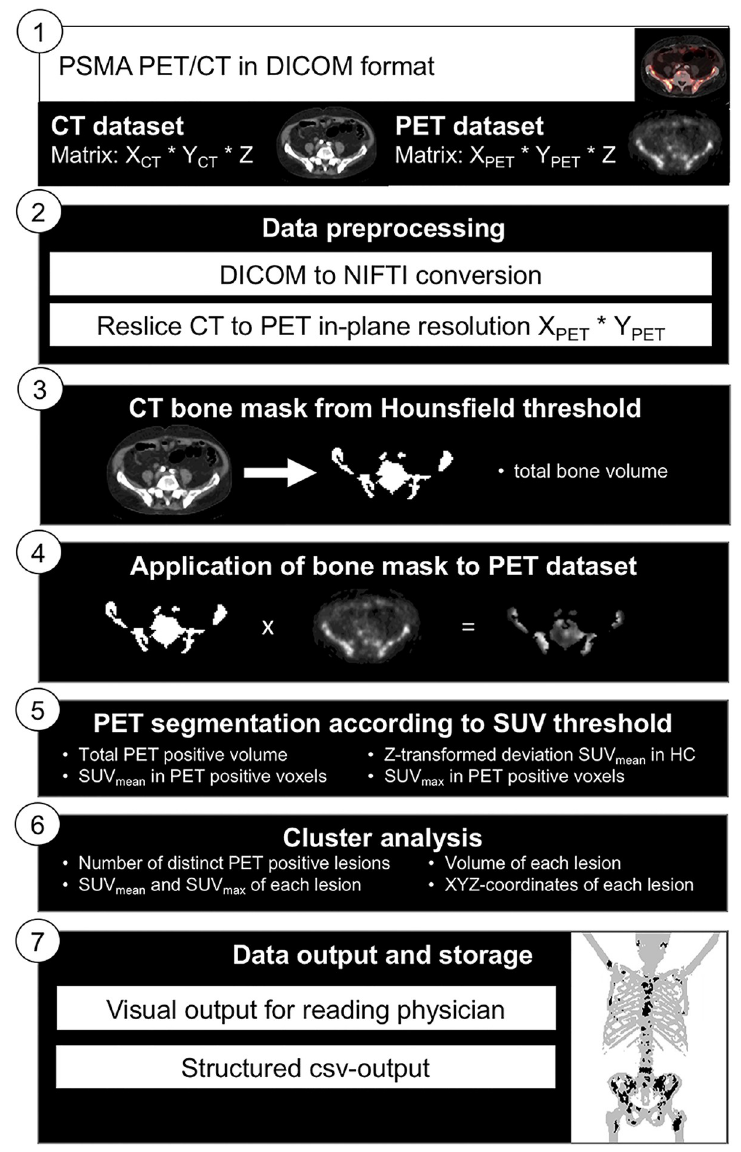
Fig 1. Algorithmic functionality of automated bone-VOI delineation and metastasis load quantification with EBONI in an exemplary patient with known osseous metastases of prostate cancer. csv = comma-separated values; HC = healthy controls. This figure was originally published in JNM [10]. Hammes et al. EBONI: A Tool for Automated Quantification of Bone Metastasis Load in PSMA PET/CT. J Nucl Med. 2018 Jul;59(7):1070–1075 by the Society of Nuclear Medicine and Molecular Imaging,